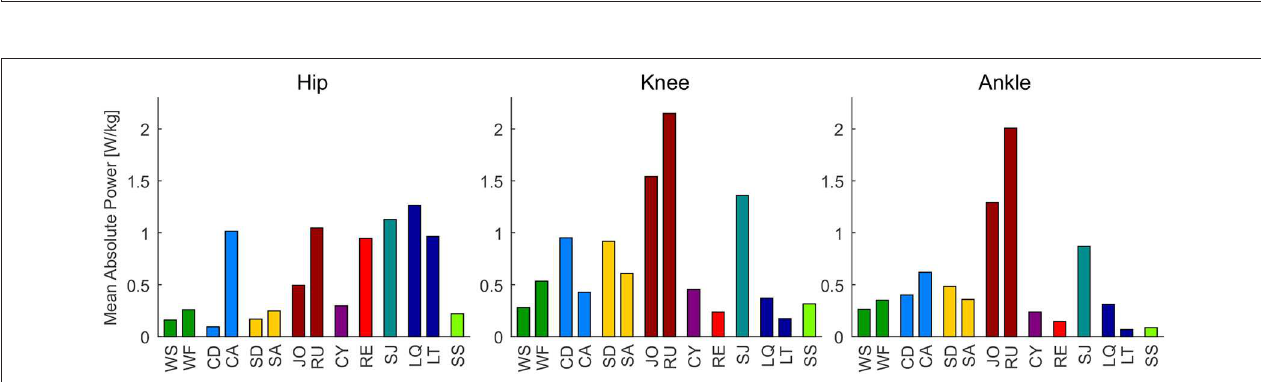
FIGURE 4 | Maximum power vs. maximum moment of the hip, knee, and ankle for all analyzed movements. Walking slow (WS), walking fast (WF), climbing descend (CD), climbing ascend (CA), stair ascend (SA), stair descend (SD), jogging (JO), running (RU), cycling (CY), recovery (RE), squat jump (SJ), squat lifting (LQ), stoop lifting (LT), sit to stand (SS).